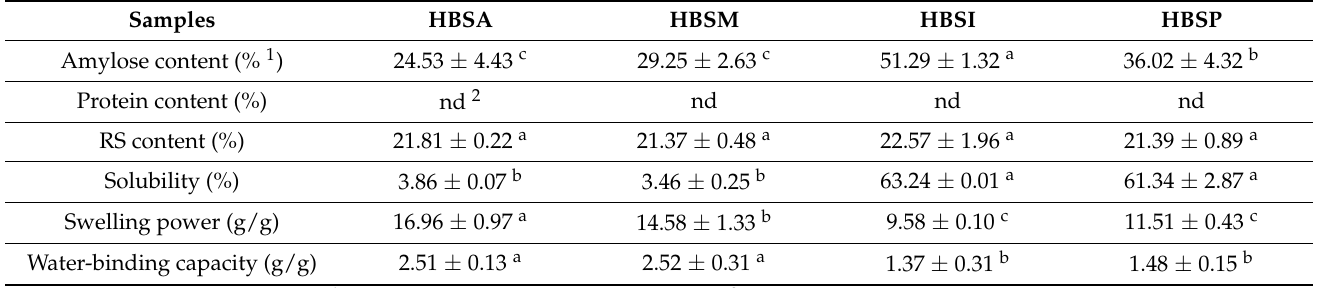
Table 1. Physicochemical characterizations of HBSA, HBSM, HBSI, and